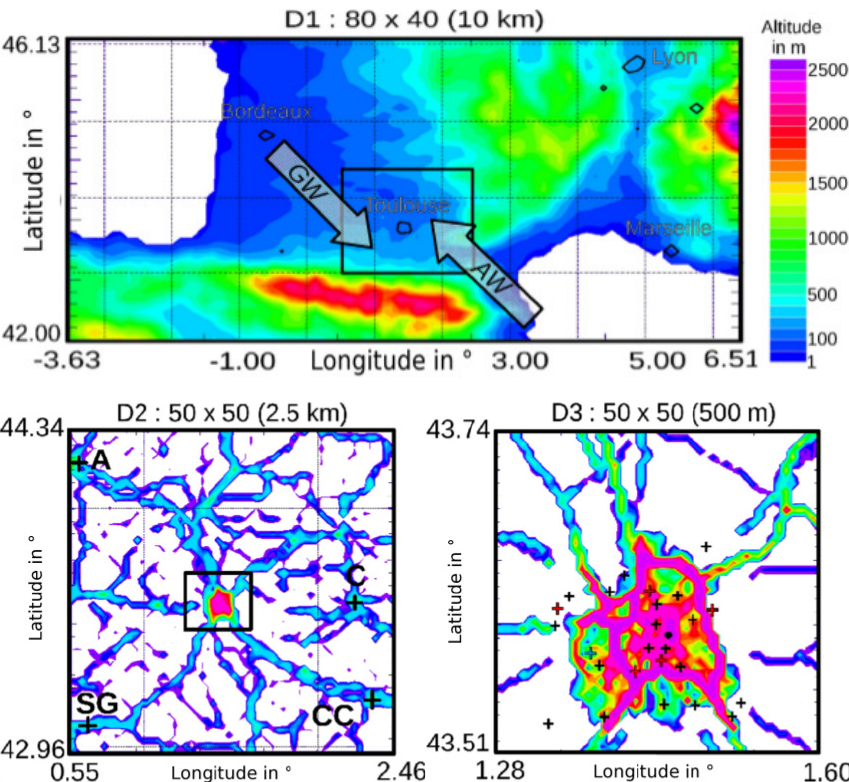
Fig. 1. The three nested domains color-coded for (a) elevation above sea level in meter, (b) and (c) and black carbon emissions in ppbms − 1 on 3 July 10:00UTC. In (a) the arrows symbolise the two dominant wind regimes AW for the Autan wind and GW for the general wind. The black crosses over the 2nd domain (b) mark the main regional cities: A for Agen, SG for Saint-Gaudens, CC for Carcassonne, and C for Castres. The crosses over the 3rd (c) domain denote the observational network; black and red crosses show the light meteorological stations and the gaseous chemistry stations,